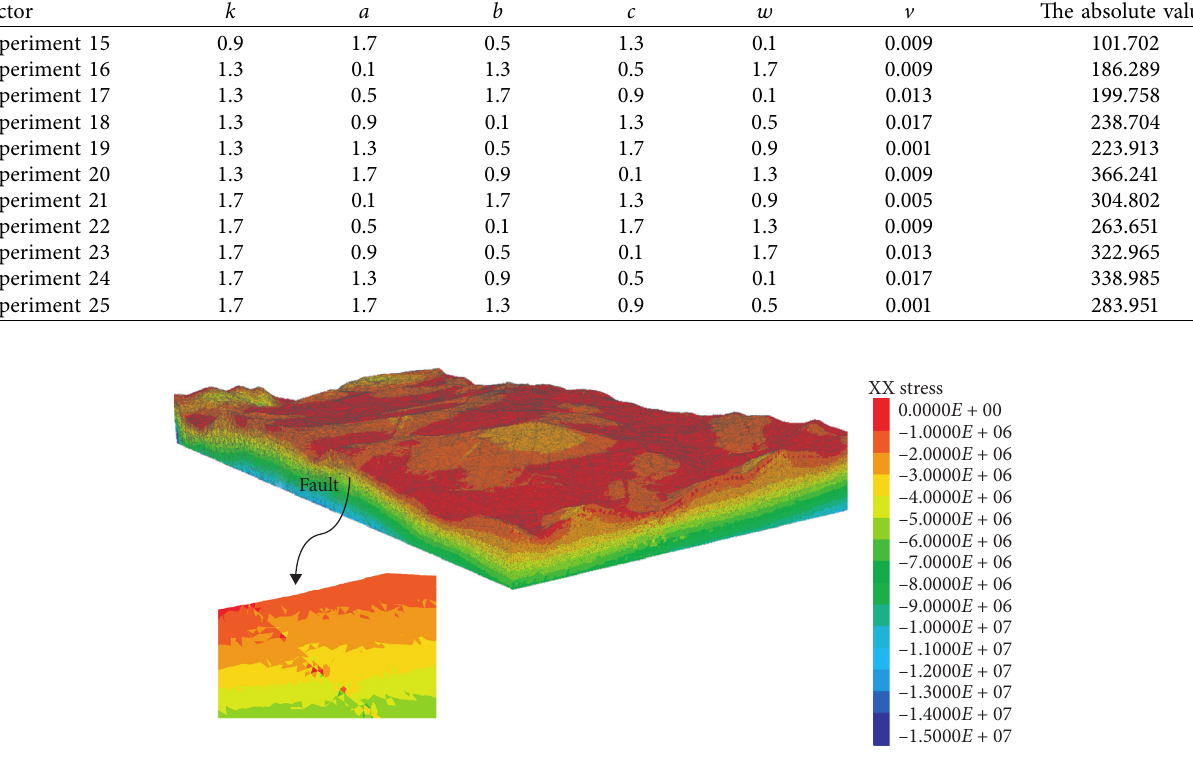
Figure 6: Horizontal in situ stress component in X direction (E-W direction).